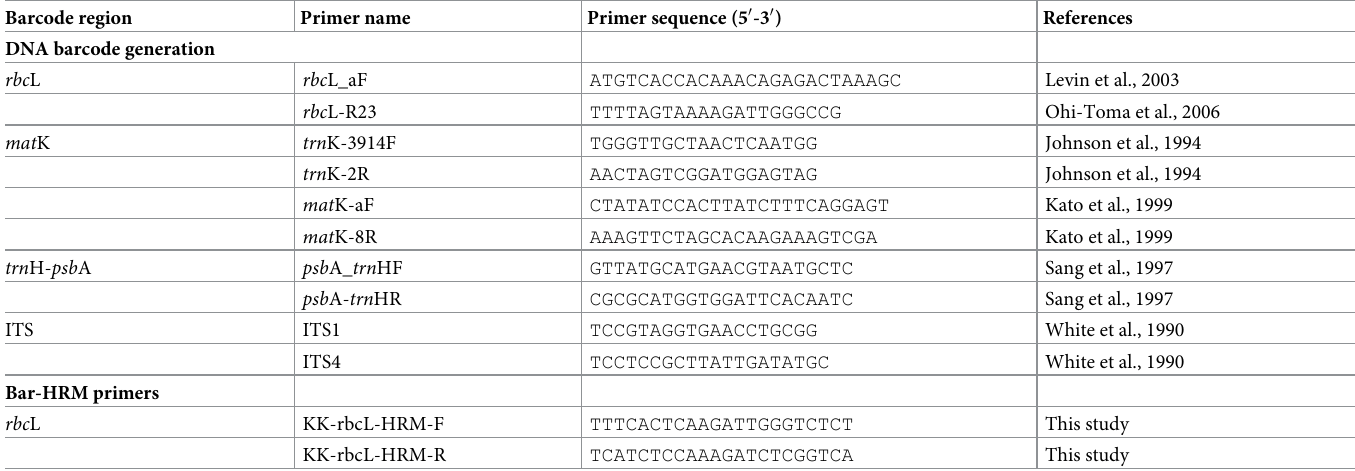
Table 2. Primers for DNA barcode generation and Bar-HRM analysis. Barcode